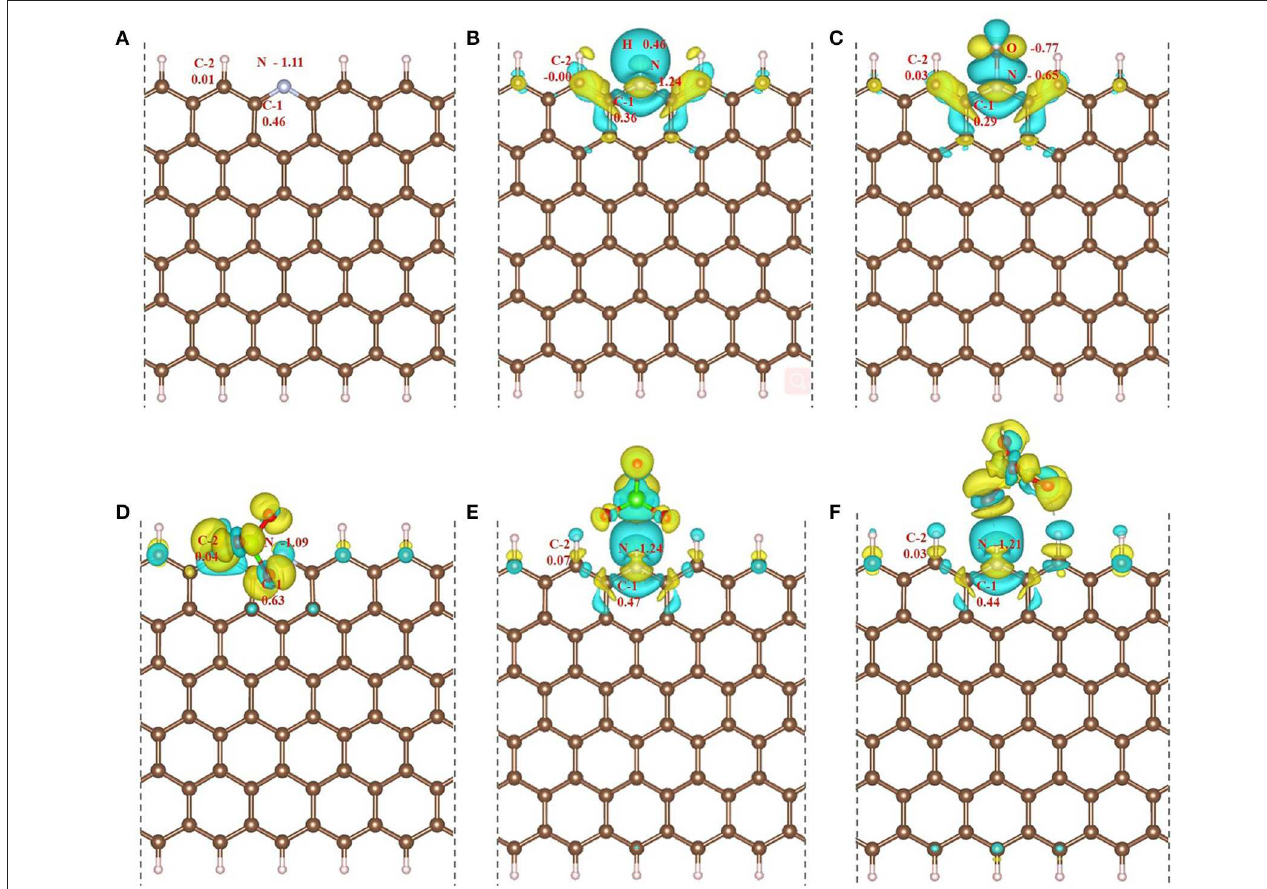
FIGURE 8 | Differential charge density distributions (between absorbed and un-adsorbed structures) and Bader charge of the adsorption sites on (A) N-GR, (B) N-GR/H, (C) N-GR/OH, (D) N-GR/ClO − 4 , (E) N-GR/H/ClO − 4 , and (F) N-GR/H/SO 2 − 4 . The Yellow represents the electron accumulation area, and the blue represents the electron loss area. The isosurface value is set to 2.5 × 10 − 3 e/Bohr 3